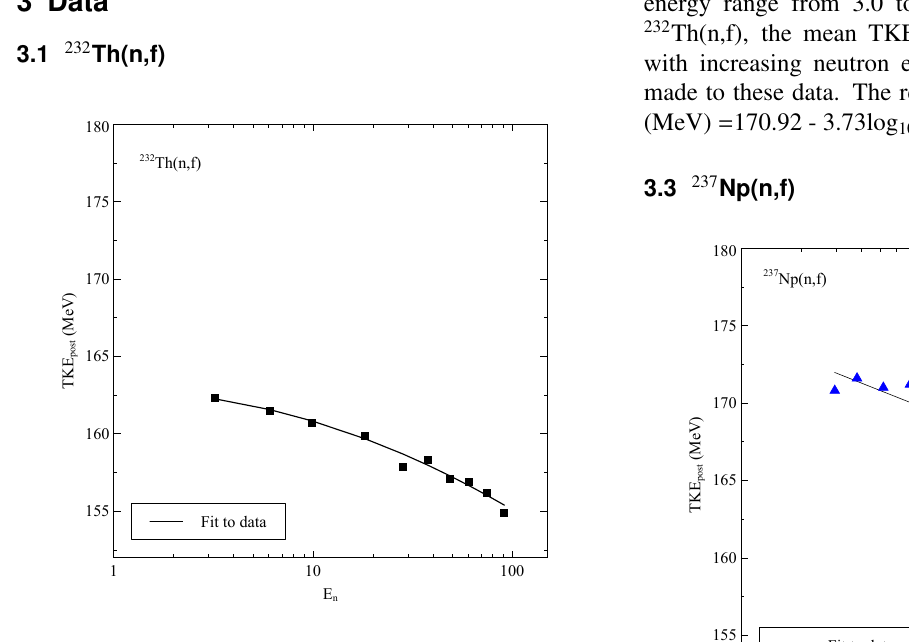
Figure 1. The average post-fission TKE measured for the 232 Th(n,f) reaction as a function of neutron energy.